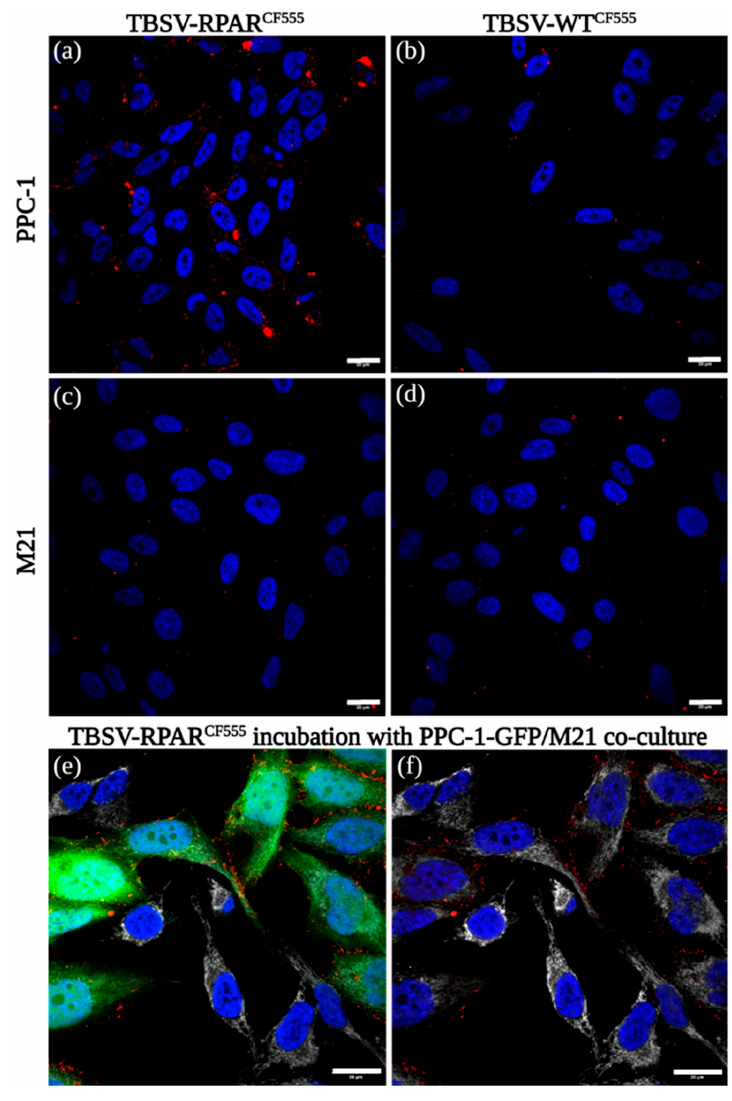
Figure 4. TBSV-RPAR NPs target NRP-1-expressing cells. Confocal microscopy images of PPC- 1 or M21 cells incubated at 37 ◦ C for 1 h with TBSV-RPAR CF555 ( a , c ) or TBSV-WT CF555 ( b , d ). Red = TBSV NPs; blue = DAPI (nuclei). ( e , f ) TBSV-RPAR CF555 binding to co-culture of PPC-1-GFP and M21 cells. TBSV-RPAR CF555 NPs are taken up only by GFP-positive PPC-1 cells. Red = TBSV-NPs; blue = DAPI (nuclei); green = GFP expressed in PPC-1 cells; white = p32. Panel f is not showing the GFP fluorescence channel. Scale bars = 20 µ